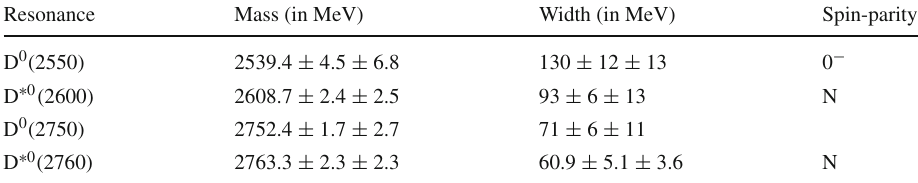
UN unnatural, N natural